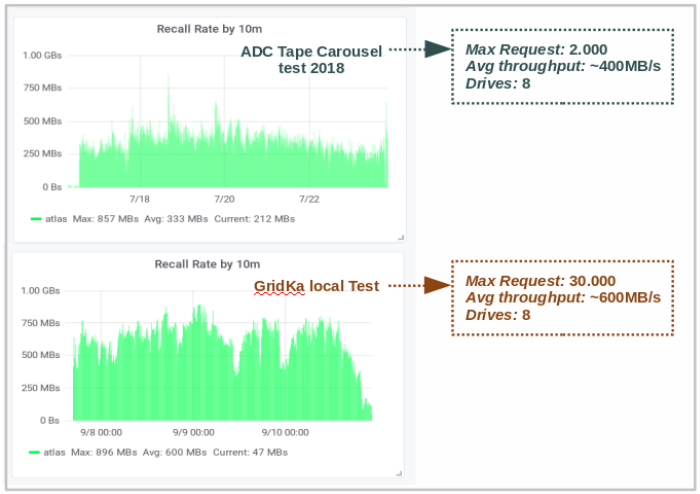
Figure 2: The di ff erence in tape recall throughput when the maximum number of simultaneous requests was 2.000 and